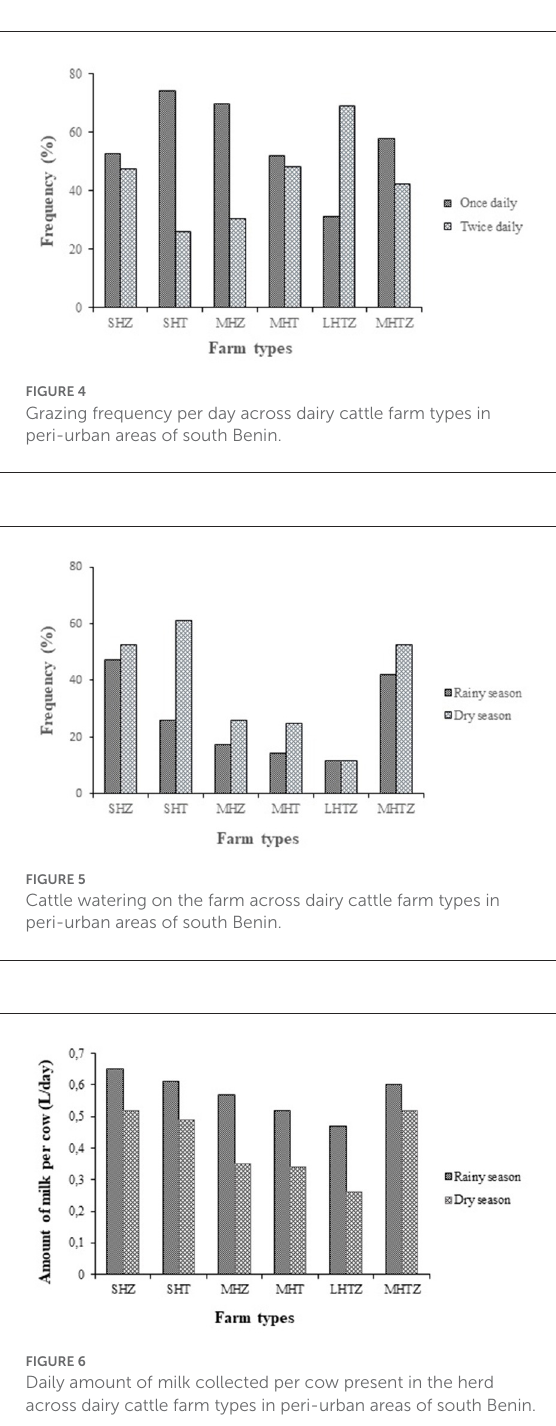
Constraints of peri-urban dairy farming